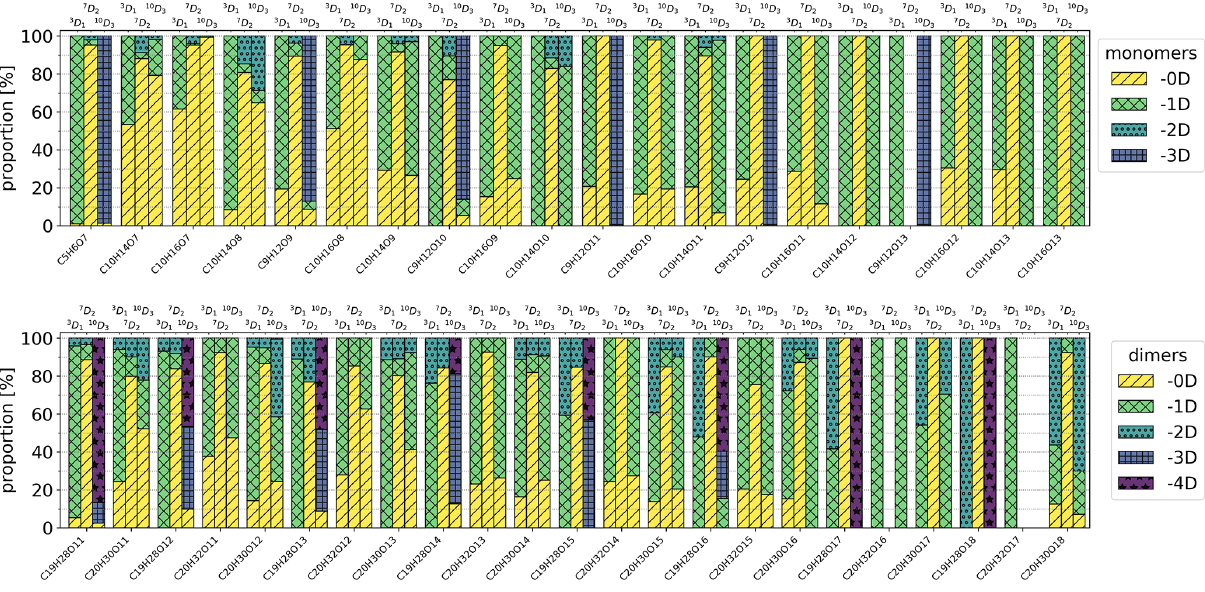
Figure A3. Isotopic distributions of all inspected peaks. The colour shows how many deuterium atoms have been lost from the precursor during the formation of the HOM isotope that corresponds to the main HOM on the x axis. For example, in the case of the 3 D 1 precursor and the C10H14O7 compound, -0D corresponds to C10H13DO7 and -1D corresponds to C10H14O7. The entry for -4D is excluded from the upper legend as there were no corresponding compounds in the inspected